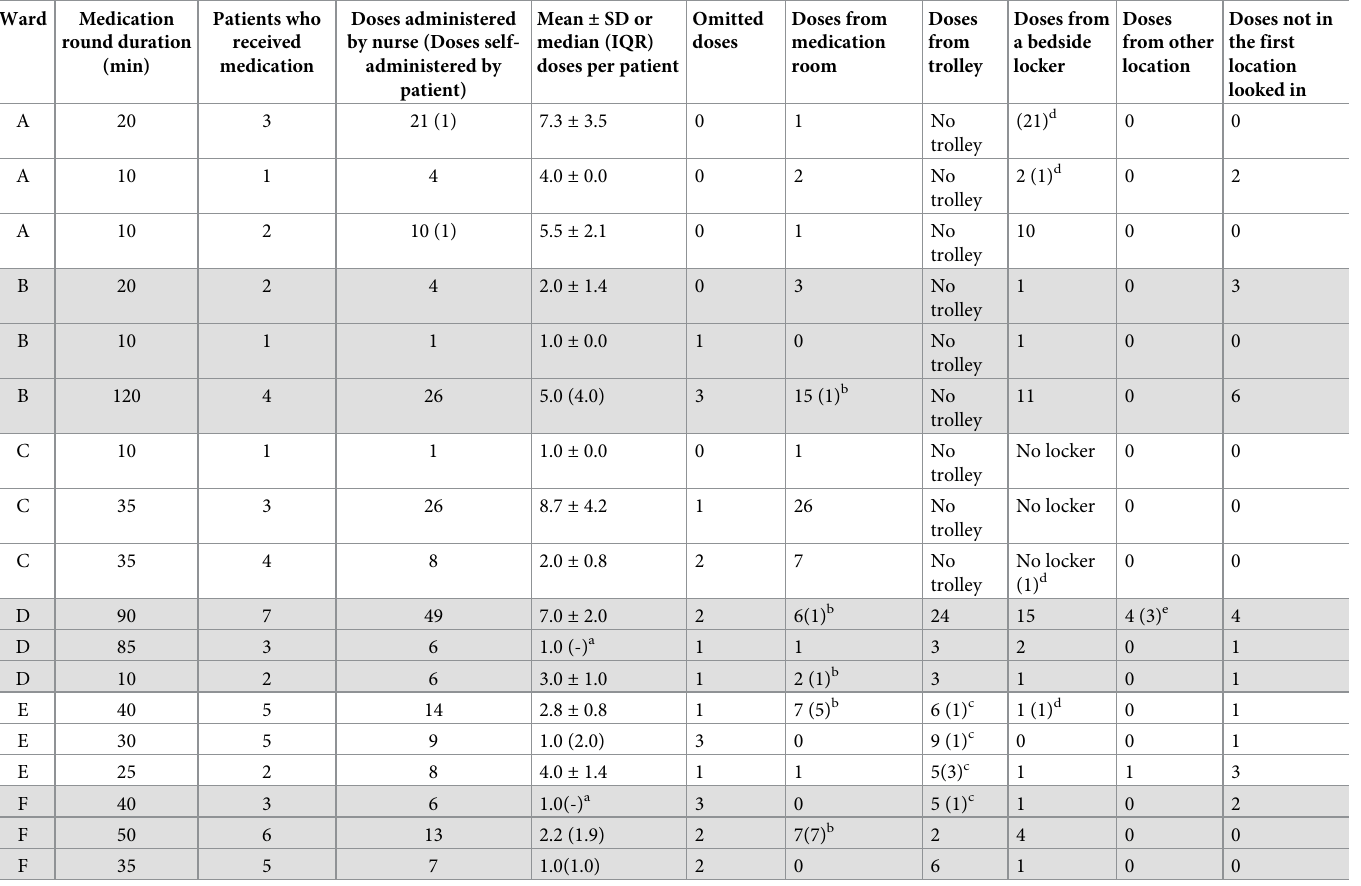
Table 4. Descriptive data from six wards collected during medication round